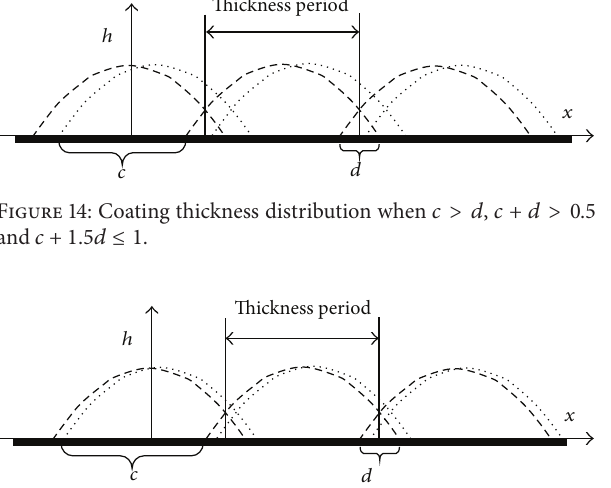
Figure 15: Coating thickness distribution when 𝑐 > 𝑑 , 𝑐 + 𝑑 > 0.5 and 𝑐 + 1.5𝑑 > 1 .